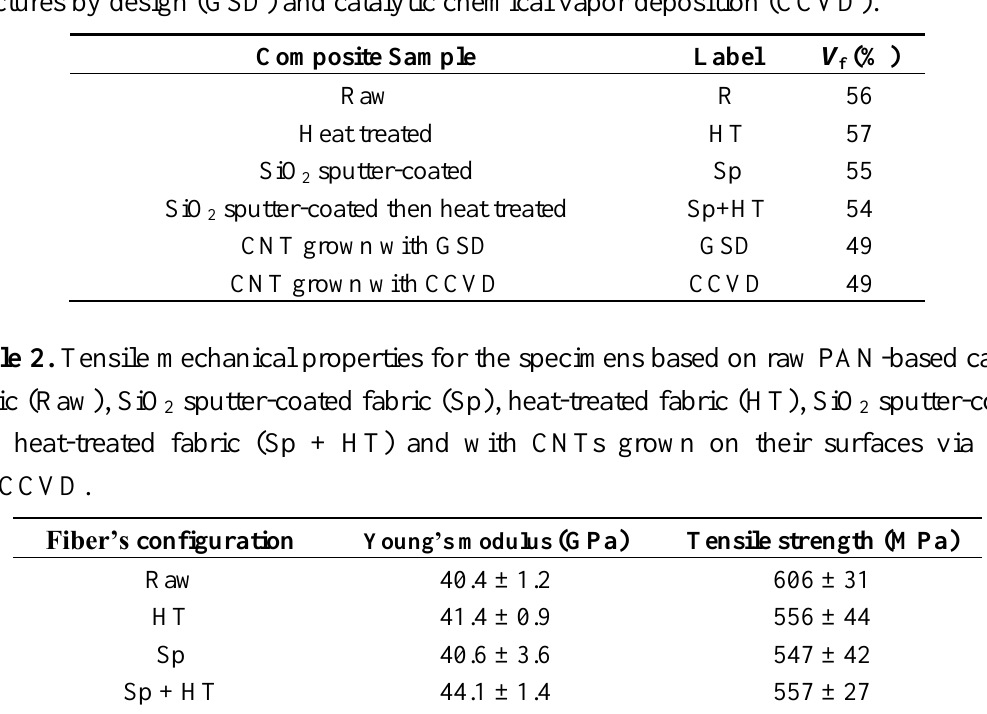
sputter-coated then 2